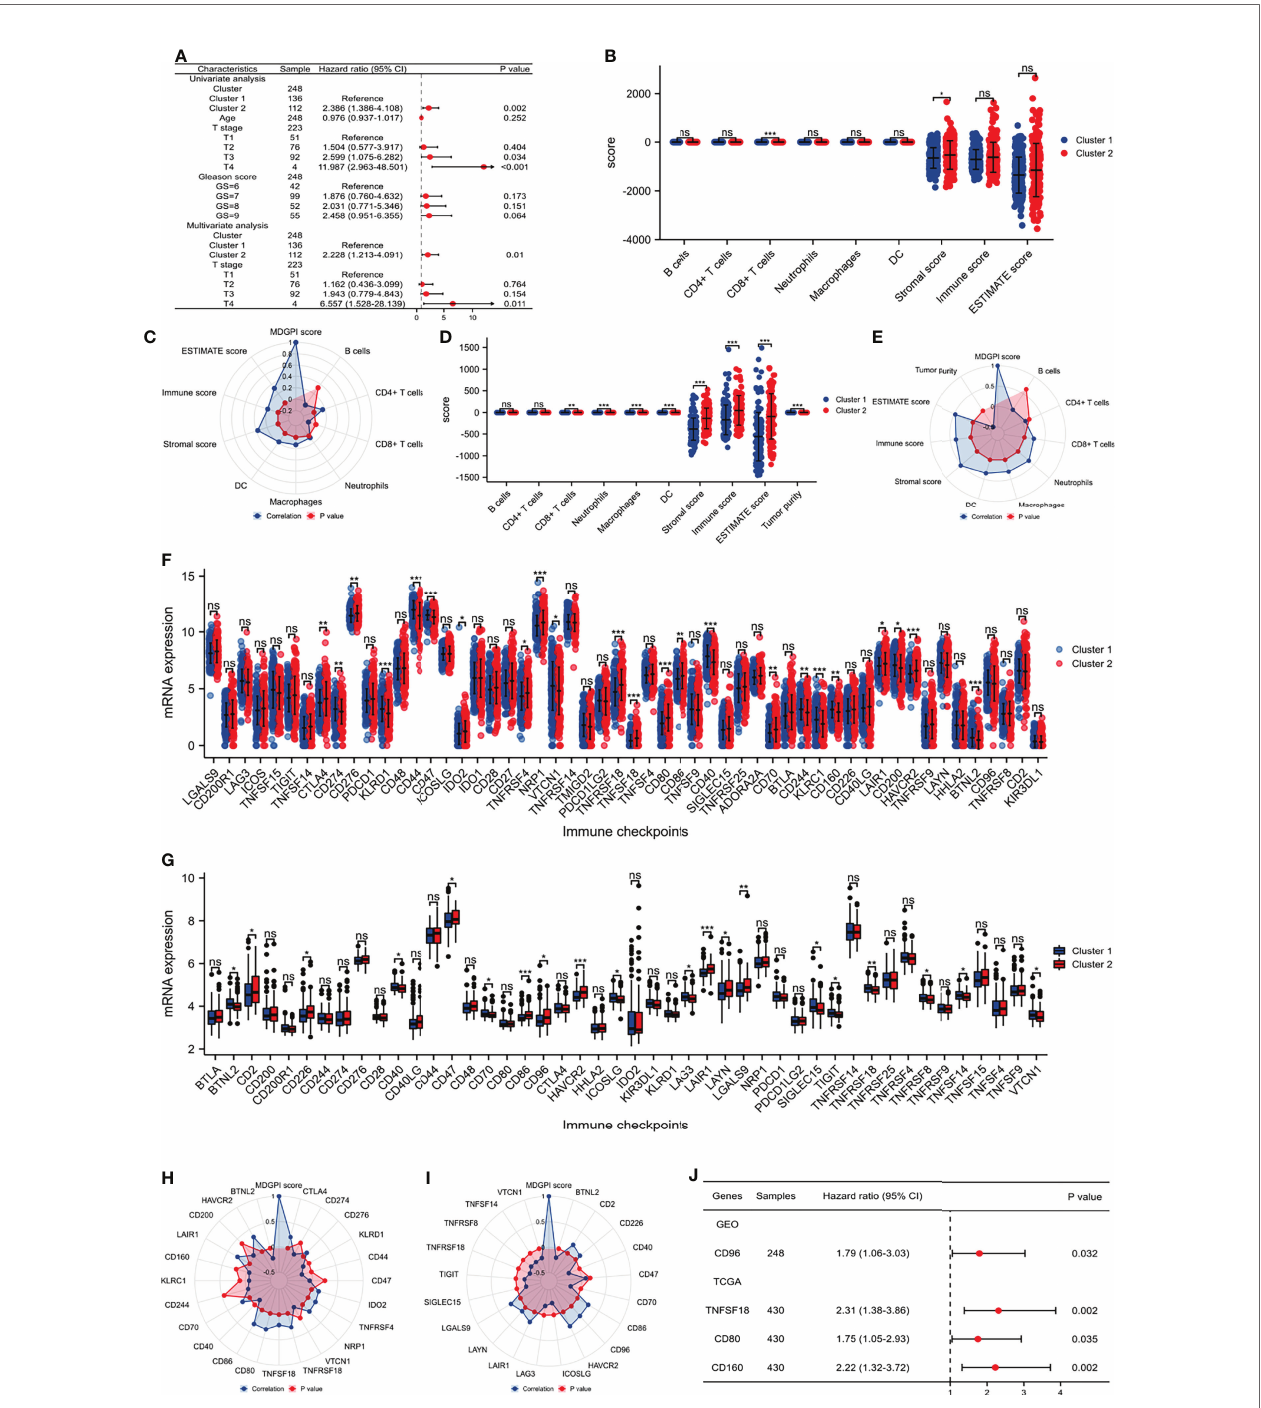
FIGURE 3 | Tumor immune microenvironment and checkpoints analysis. (A) COX regression analysis showing the results of clusters and other clinical parameters in the GSE116918 (17); (B) comparison between the two clusters for immune cells in the TCGA database; (C) radar plot showing the correlations between MDGPI score and immune cells in the TCGA database; (D) comparison between the two clusters for immune cells in the GSE116918 (17); (E) radar plot showing the correlations between MDGPI score and immune cells in the GSE116918 (17); (F) comparison between the two clusters for immune checkpoints in the TCGA database; (G) comparison between the two clusters for immune checkpoints in the GSE116918 (17); (H) radar plot showing the correlations between MDGPI score and immune checkpoints in the TCGA database; (I) radar plot showing the correlations between MDGPI score and immune checkpoints in the GSE116918 (17); (J) forest plot showing checkpoints associated with BCR-free survival in the TCGA database and GSE116918 (17). BCR, biochemical recurrence; MDGPI, mitochondrial dysfunction-related genetic prognostic index. ns, p ≥ 0.05; *, p <0.05; **, p <0.01; ***, p